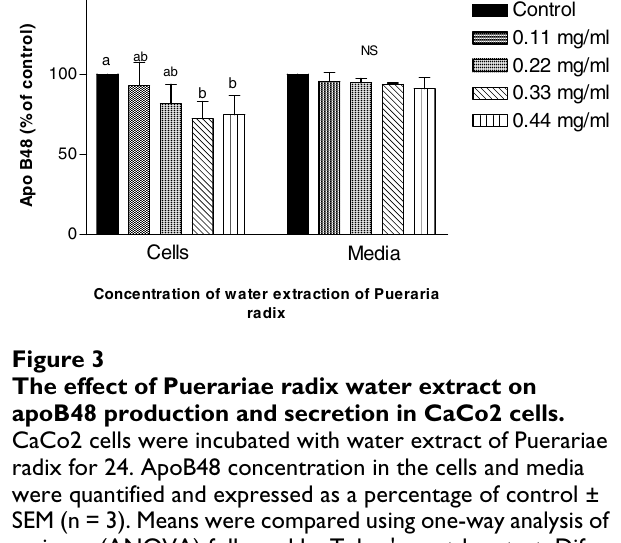
The effect of Puerariae radix water extract on apoB48 production and secretion in CaCo2 cells. CaCo2 cells were incubated with water extract of Puerariae radix for 24. ApoB48 concentration in the cells and media were quantified and expressed as a percentage of control ± SEM (n = 3). Means were compared using one-way analysis of variance (ANOVA) followed by Tukey's post-hoc test. Dif- ferent letters above bar graphs indicate significance from each other at p < 0.05. NS: Not significant at p > 0.05.